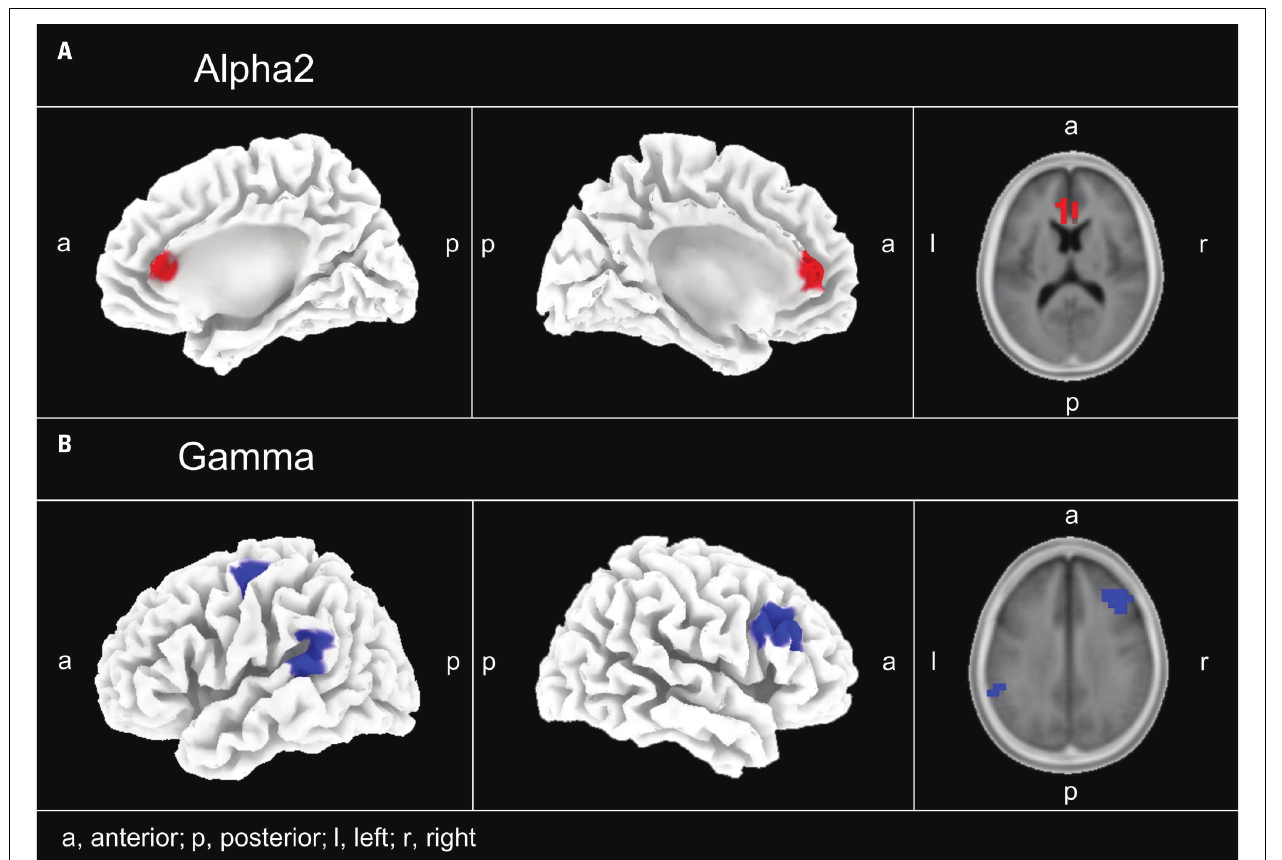
FIGURE 3 | EEG source localization (sLORETA) power maps for the PC–NPC paired-groups comparison. (A) Alpha2 (10–12 Hz) increased (color-coded red) in the right and left anterior cingulate cortex (BA 24, 32). (B) Gamma band power decreased (color-coded blue) with pitch change in the left parietal (BA 40), left temporal (BA 22, 42), right frontal (BA 9, 46), and left frontal (BA 4, 6)